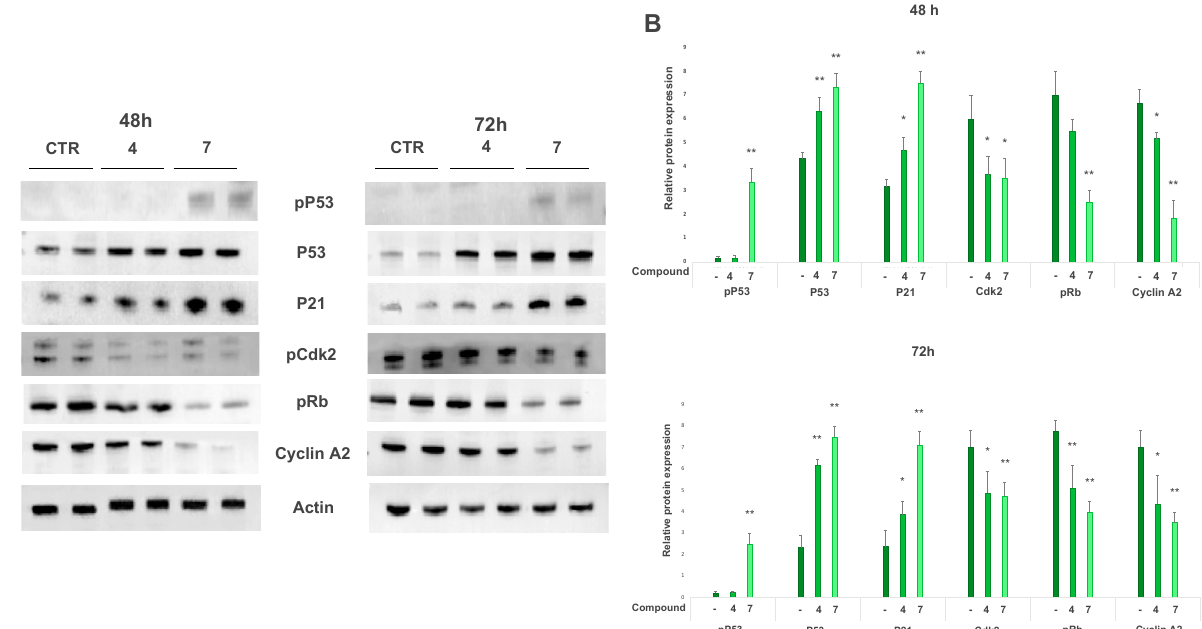
Figure 3. Cryptotanshinone ( 4 ) and salviolone ( 7 ) effect on the protein expression involved in cell cycle progression and pro-survival signaling. A375 melanoma cells were cultured in the presence (20 µ M) or absence of salviolone ( 7 ) or cryptotanshinone ( 4 ) for 48 and 72 h. ( A ) Representative immunoblot showing the expression level of cell-cycle-related proteins; ( B ) histograms show the mean values ± SD of the protein expression level measured by densitometry deriving from three to four independent experiments. All comparisons were performed vs. each control sample after normalization with β -actin expression, * p < 0.05; ** p < 0.01.